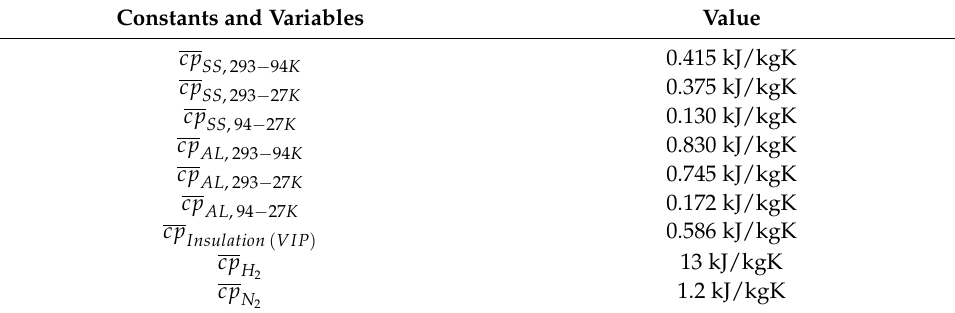
Table 4. Constants and variables used in the analytical